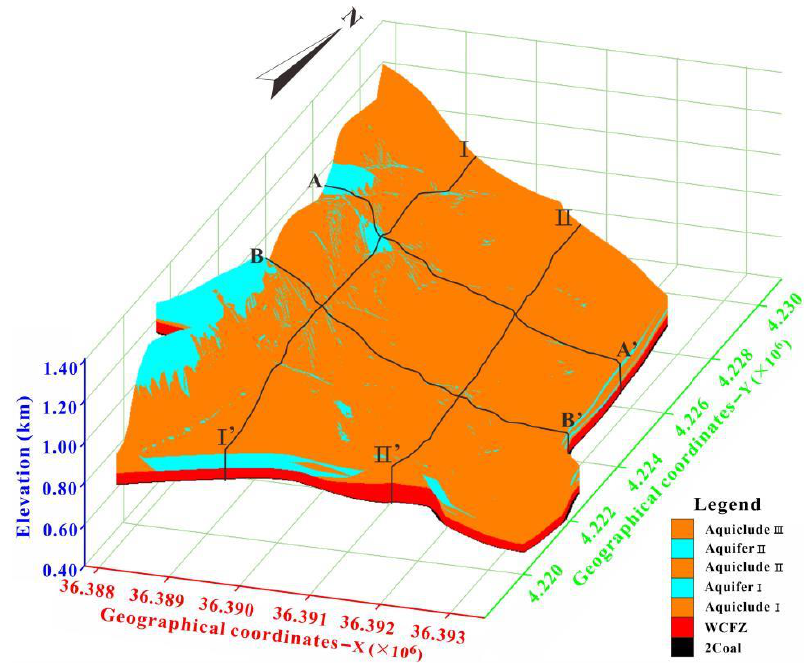
Figure 6. 3D hydrogeological structure model of WFCZ.